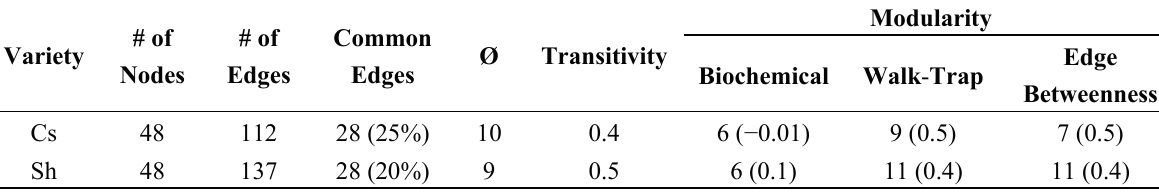
Table 3. The main Graph theory based properties calculated for the correlation-based networks of Cabernet Sauvignon (Cs) and Shiraz (Sh) varieties.